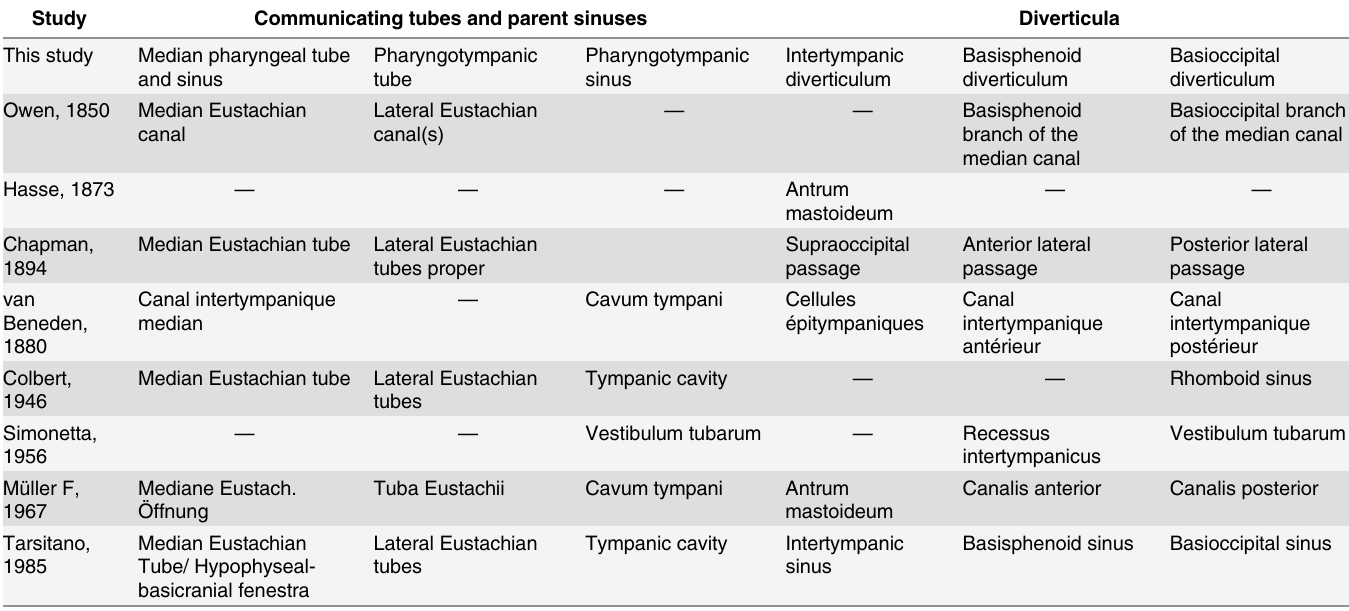
Table 2. Synonyms of paratympanic pneumatic structures used in this study and selected